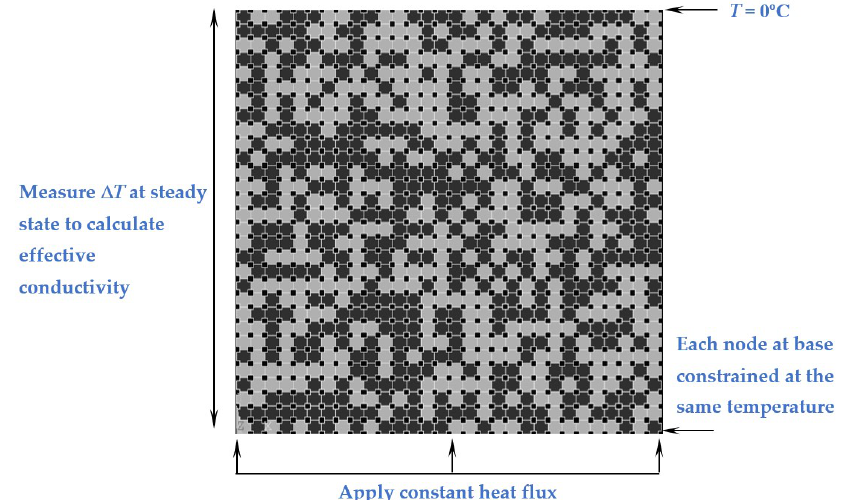
Figure 1. An image of a typical 30 × 30 thermal network, where α 1 = 0.5. A heat flux was applied to the base, all of which are to the same temperature. The upper section of the network was held at 0 °C. Phase k 1 (black) has a variable thermal conductivity from 10 −4 to 10 4 W·m −1 ·K −1 and k 2 (grey) is a constant conductivity of 1 W · m − 1 · K − 1 .